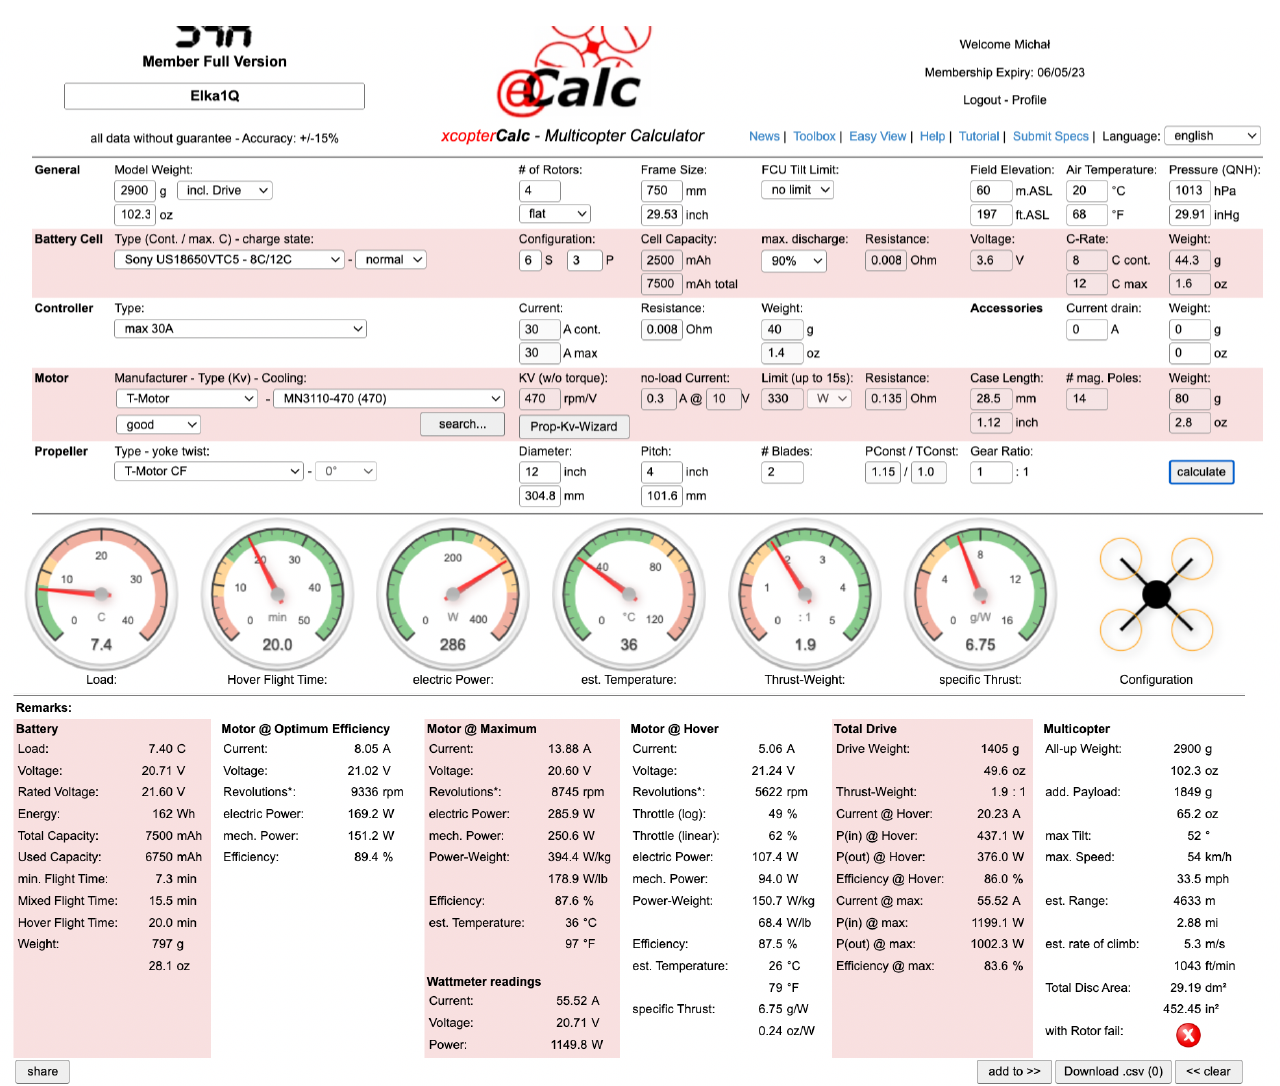
Figure 5. The eCalc [30] tool helped us find the best electric propulsion setup for the Elka1Q drone ; disclaimer from eCalc: * The manufacturer limitation is NOT monitored (relates to motor revolutions).